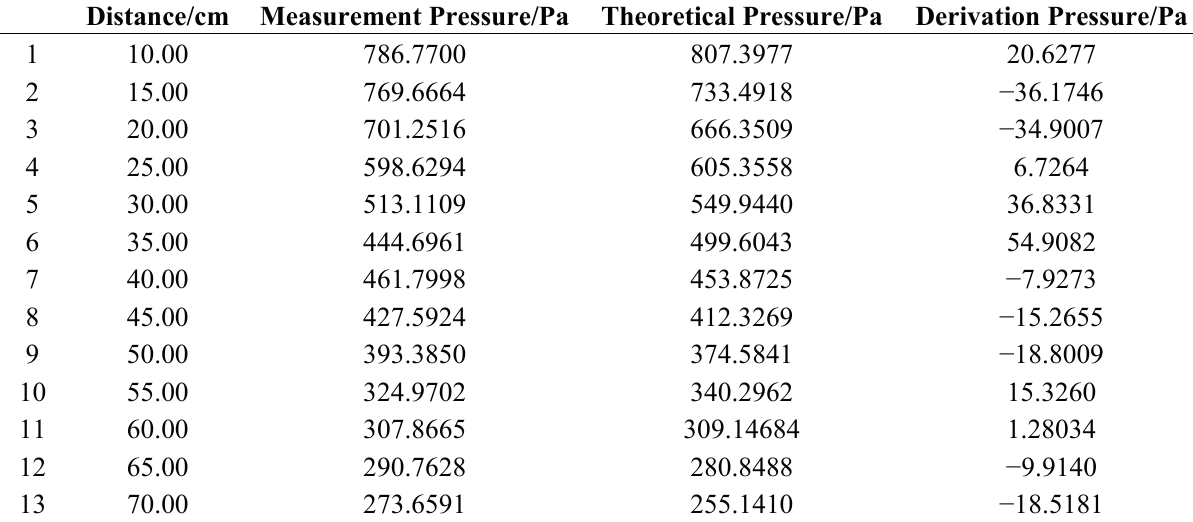
Table 3. The sound pressure at different